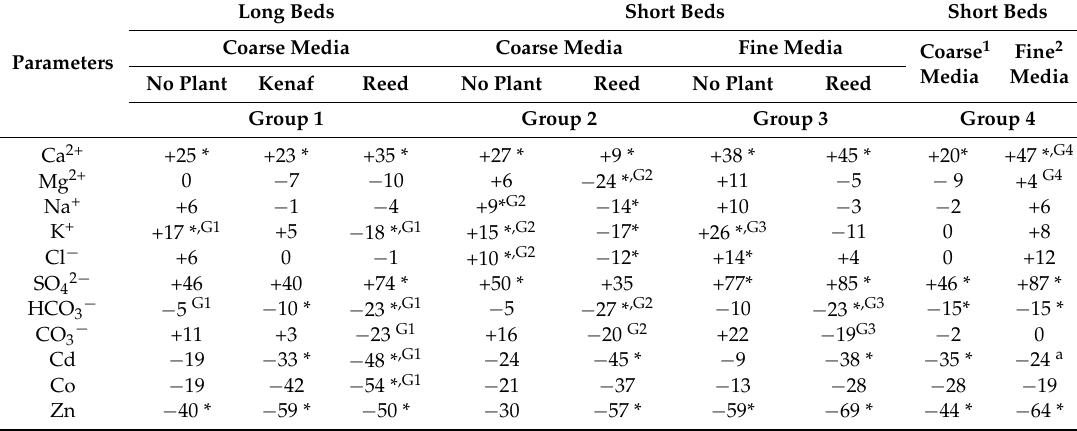
Table 3. Mass flow changes (%) for major anions, cations, micronutrients, and heavy metals.